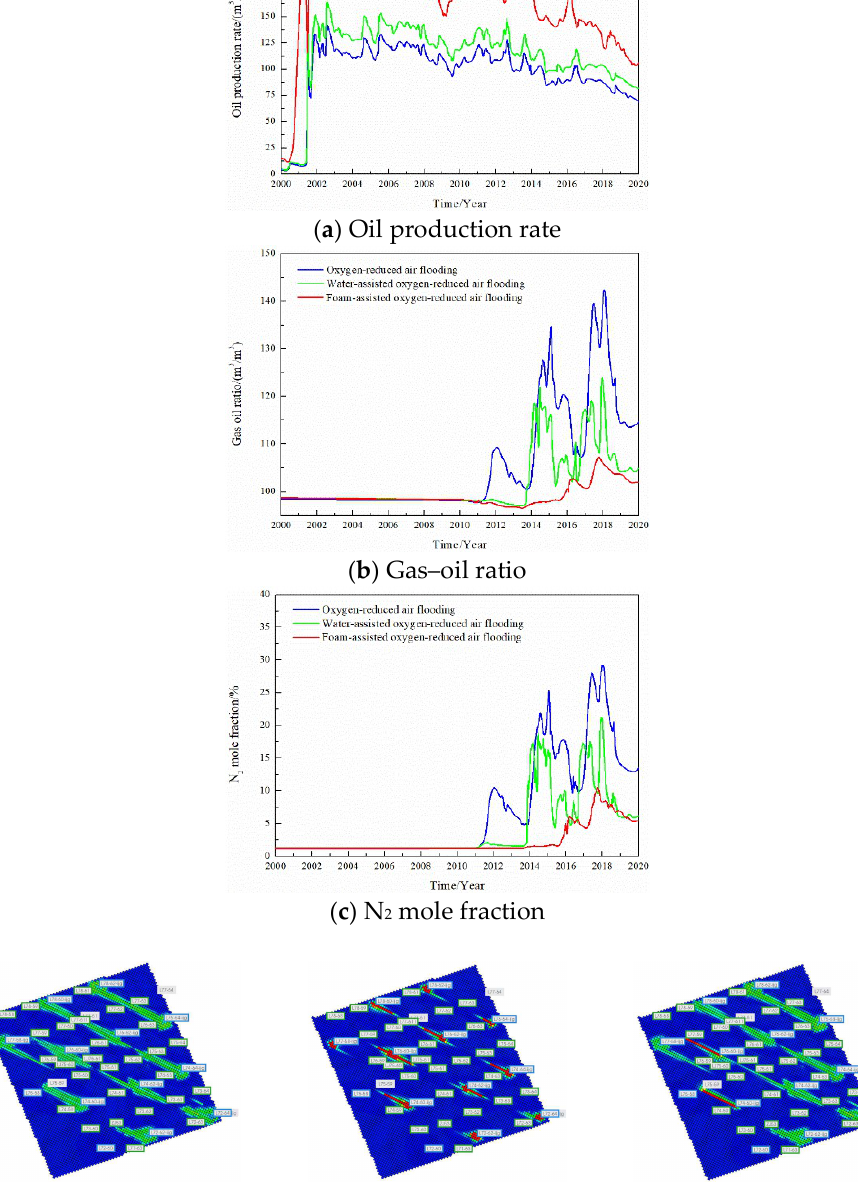
Figure 9. Effect of the gas injection mode on the dynamic production performance.